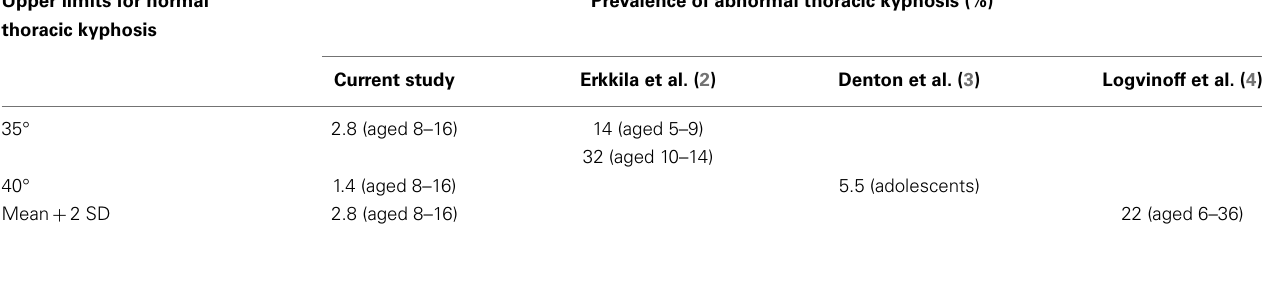
Prevalence of abnormal thoracic kyphosis